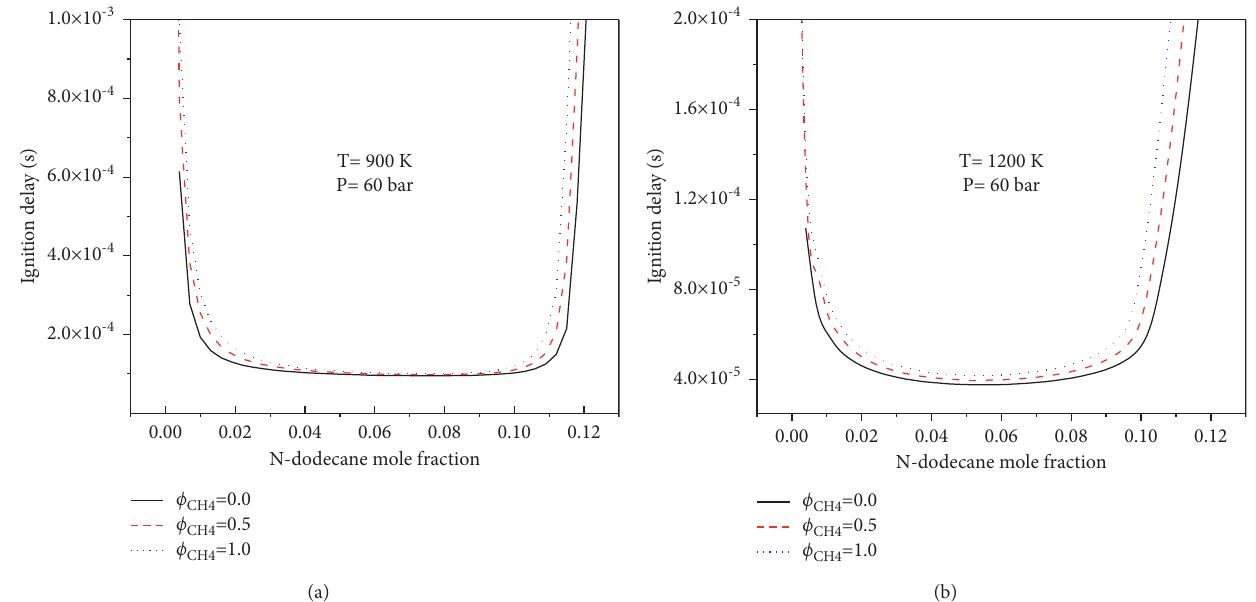
Figure 5: Ignition delay of n-dodecane with different mole fractions at 900K and 1200K methane-air mixture corresponding to ϕ 0.5, and